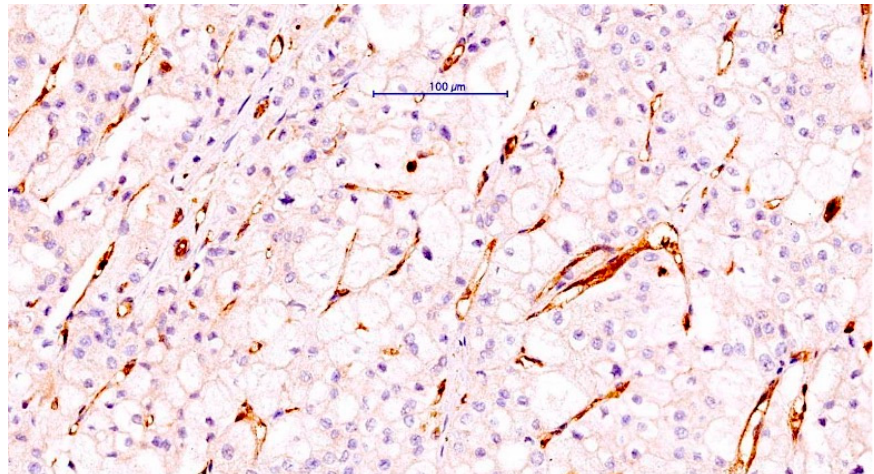
Figure 5. CLIC1 positivity inside the intratumor blood vessels endothelium in a ccRCC case with CLIC1-negative tumor cells. Note the high CLIC1-positive microvessel density and also the hetero- geneity of their morphology. Scale bar: 100 μ m